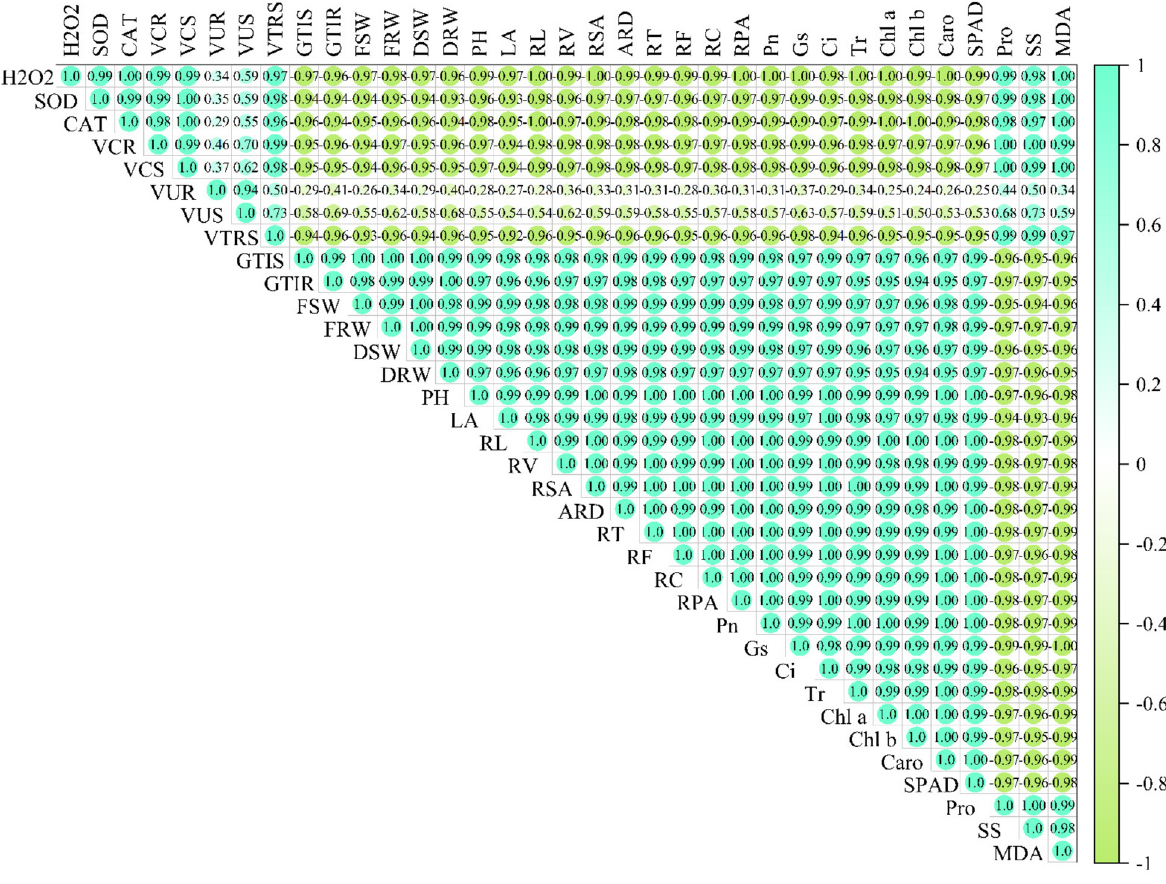
Figure 10. Correlation analysis ( p < 0.05) between various measured attributes of pepper. The abbre- viations are as follows: FSW (fresh shoot weight), DSW (dry shoot weight), FRW (fresh root weight), DRW (dry root weight), PH (plant height), LA (leaf area), RL (root length), RV (root volume), RSA (root surface area), ARD (average root diameter), RT (root tips), RF (root forks), RC (root crossings), RPA (root projected area), Pn (photosynthetic assimilation), Gs (stomatal conductance), Ci (Intercel- lular CO 2 ), Tr (transpiration rate), Chl a (chlorophyll a), Chl b (Chlorophyll b), Caro (carotenoids), SPAD (relative chlorophyll content), Pro (proline). SS (soluble sugars), MDA (Malonaldehyde), H 2 O 2 (hydrogen peroxide), SOD (superoxide dismutase), CAT (catalase), VCR (vanadium concentration in root), VCS (vanadium concentration in shoot), VUR (vanadium uptake in root), VUS (vanadium uptake in shoot), GTIS (growth tolerance index in root), GTIR (growth tolerance index in root), VTRS (vanadium translocation from root to